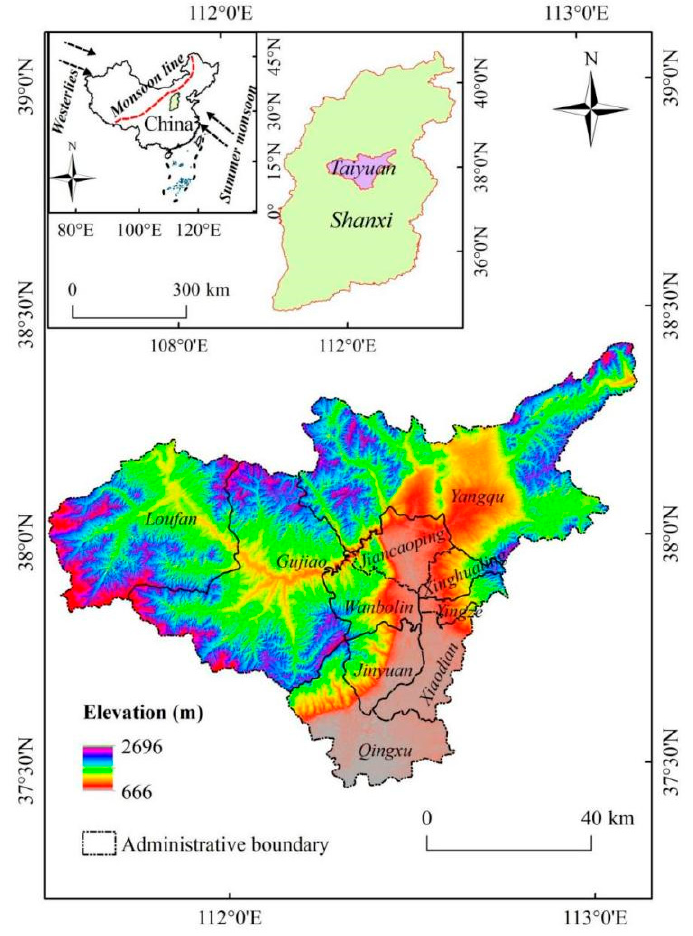
Figure 1. Map of Taiyuan city location and elevation.